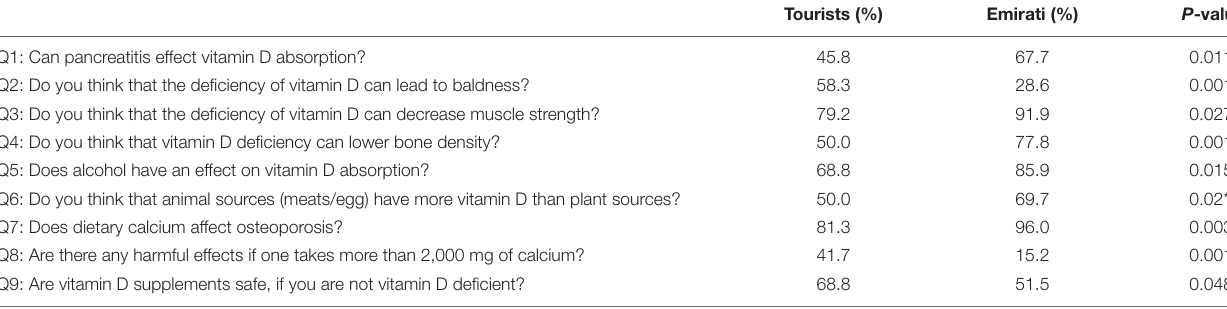
TABLE 3 | Statistically significant responses of the sample to individual questions.